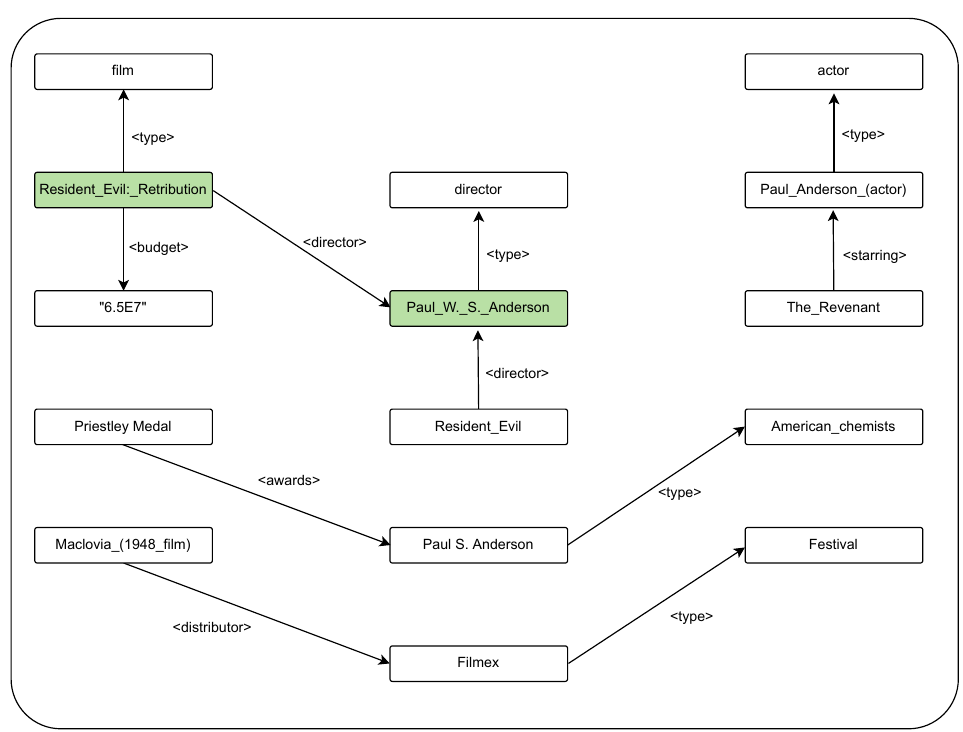
Figure 5. The correct partial RDF diagram of example